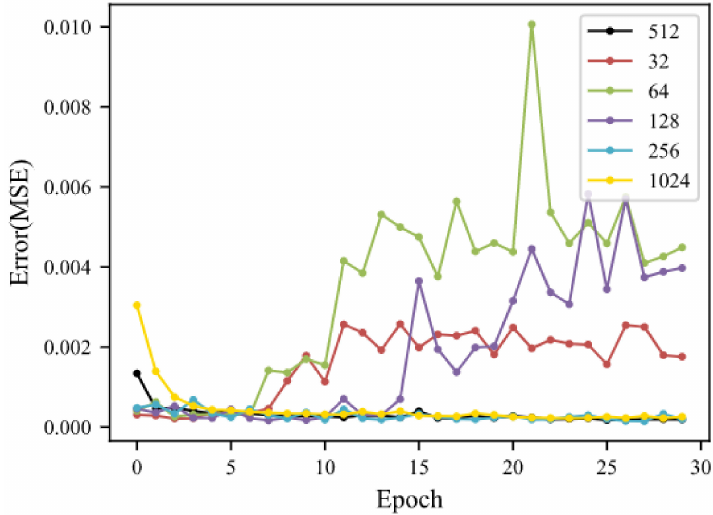
Figure 7. Model MSE